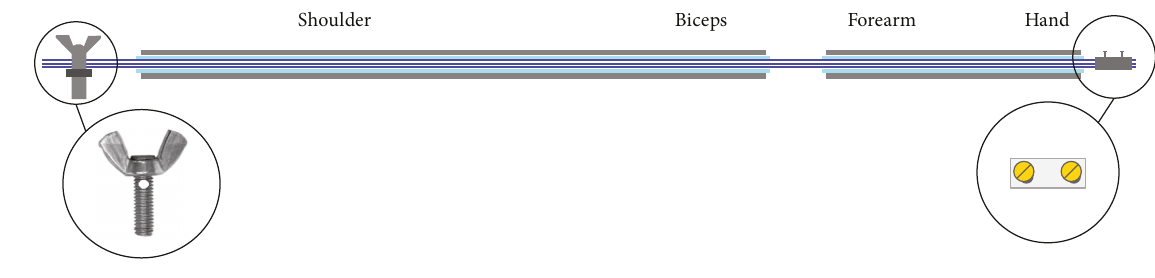
Figure 9: SMA wire crimping process for elbow exoskeleton